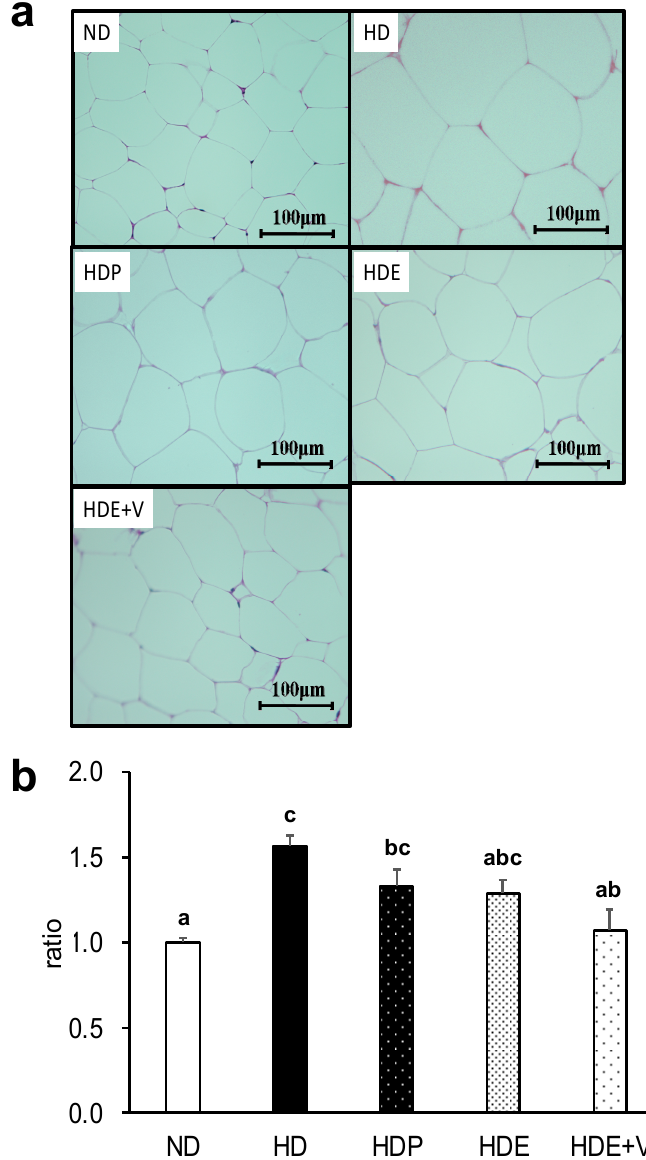
Figure 1. Effects of the intake of Euglena and vegetables on white adipose tissue in diet-induced obese mice. ( a ) Epididymal adipose tissue sections from representative mice in each group (hematoxylin & eosin, scale bar = 100 µ m). ( b ) Adipocyte size ratio values are presented as the mean ± standard error of the mean, n = 10. a,b,c Different superscript letters indicate significantly different means at p < 0.05 (refer to “Result” in detail). ND, a group fed the normal diet; HD, a group fed the high-fat diet; HDP, a group fed the high-fat diet containing 0.3% paramylon; HDE, a group fed the high-fat diet containing 1.0% Euglena; HDE + V, a group fed the high-fat diet containing 1.0% Euglena and 0.3% vegetables.